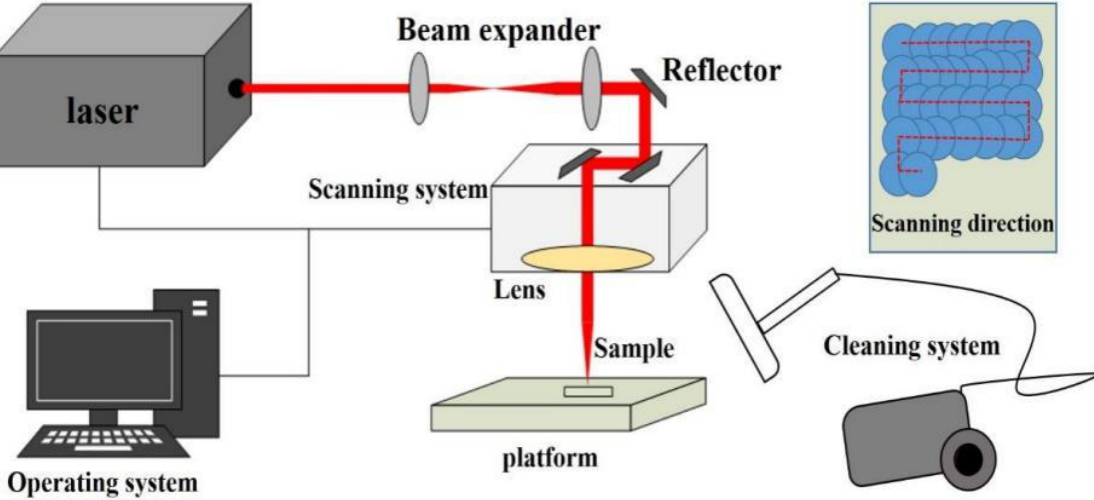
Figure 3. The two-dimension galvanometer spreads the light spot to the entire processing surface. Table 2. Experimental parameters of laser removal technology.